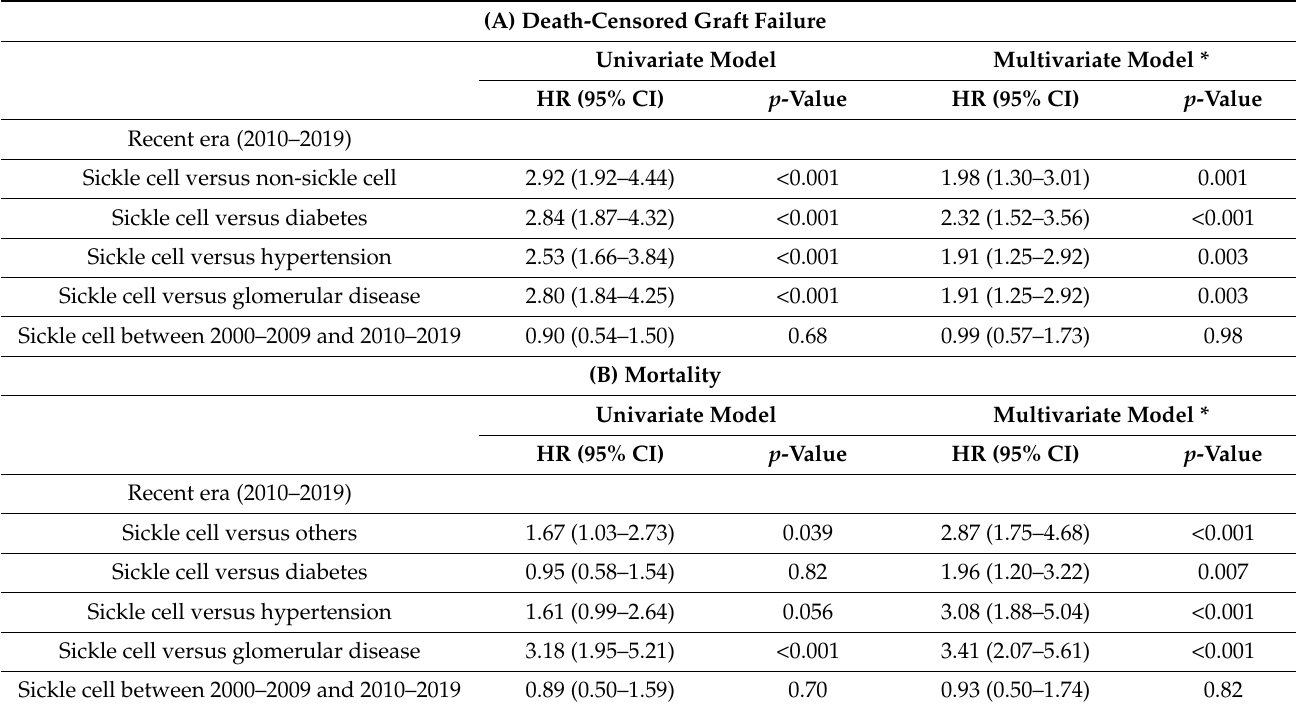
Table 2. Post-transplant outcomes of sickle cell disease compared to non-sickle cell disease. (A) Death-Censored Graft Failure